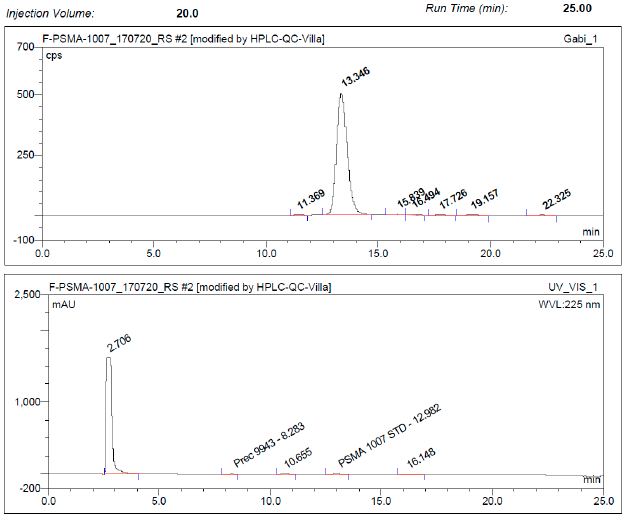
Figure 2. Cont. Figure 2.